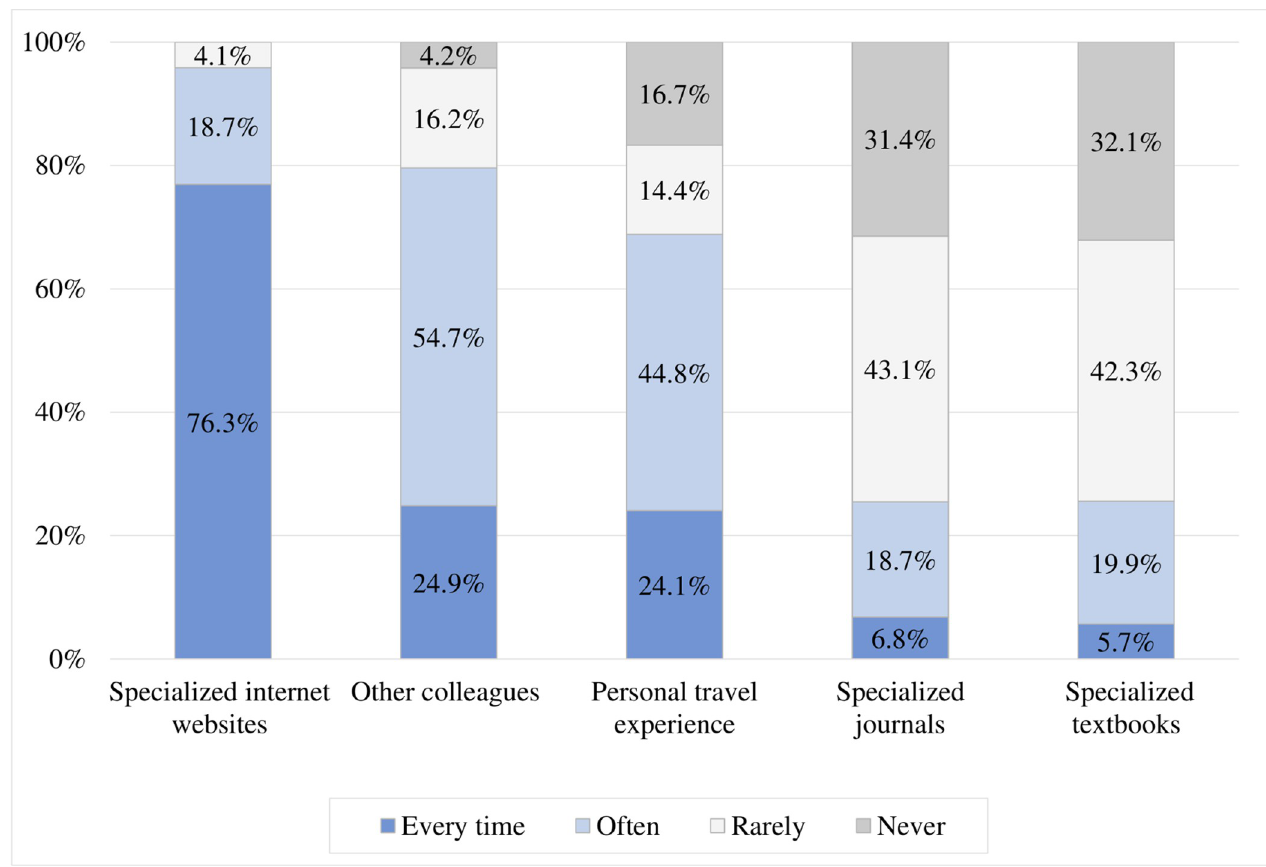
Fig 3. Information resources cited by primary care physicians for travel medicine advice (N =